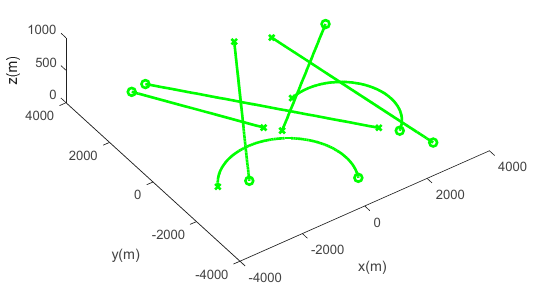
Sensors 2020 , 20 , x FOR PEER REVIEW Figure 3. Target trajectories in scenario 1. Figure 3. Target trajectories in scenario 1.